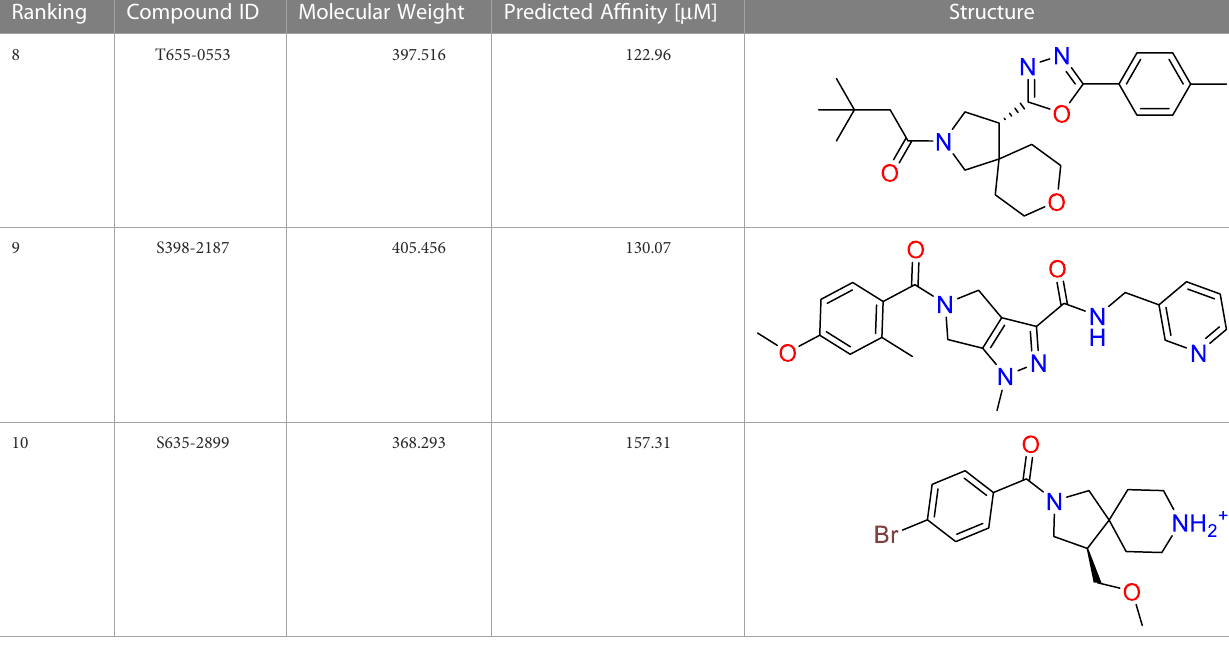
TABLE 3 Top-ranked serine covalent warheads from structure-based virtual screening against LexA, predicted with Schrödinger Covdock. Compound